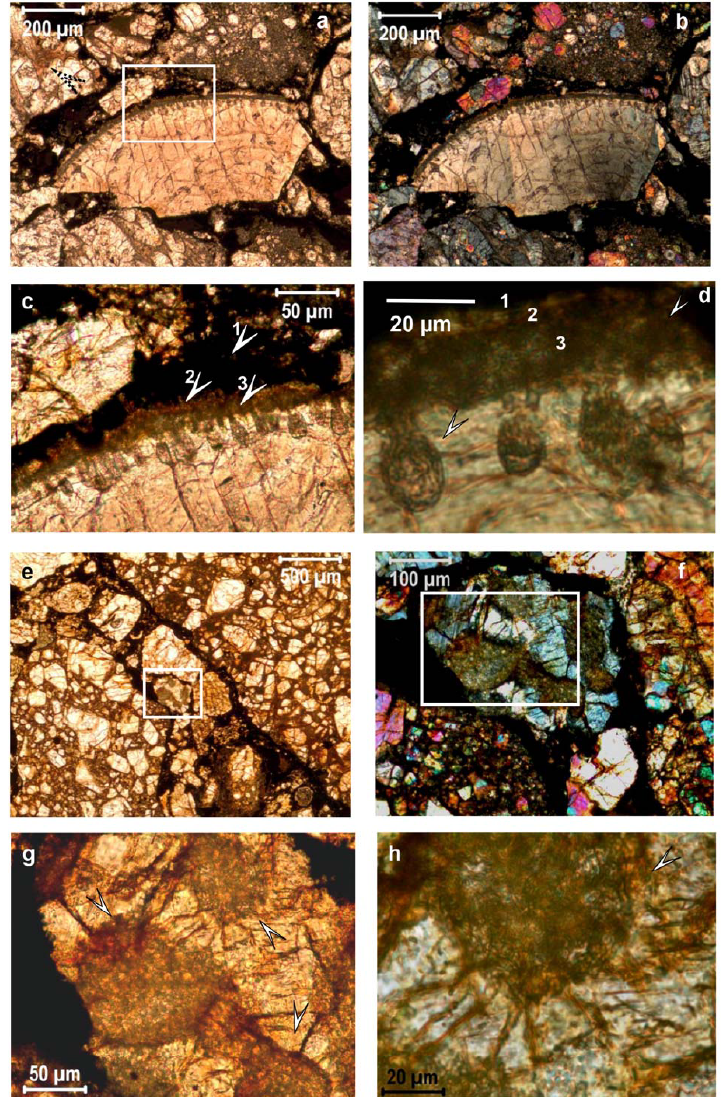
Figure 2. Characteristic microtexture of chondrites. (a) characteristic microtexture of Mező-Madaras chondrite containing chondrules (broken one in the centre), and olivine and pyroxene mineral clasts embedded in opaque fine-grained matrix (1N), dashed arrow show Fe-mobilization; (b) the crossed N photo of (a); (c) higher magnification of marked area on (a), arrows show transition from opaque ma- trix (1) towards the broken chondrule (2- brown part and 3- greenish-brown part), opaque matrix (1) consists of nanocrystalline graphite, weathered olivine and pyroxene, dickite and montmorillonite (SI. 4 - Raman spectroscopy - Mező-Madaras (MM) meteorite), brown part is weathered olivine, pyroxene, ferrihydrite, montmorillonite and dickite (2), part (3) consists of organic matter, ferrihydrite, montmoril- lonite, kaolinite and halloysite determined by Raman spectroscopy (SI. 4 - Raman spectroscopy - Mező-Madaras (MM) meteorite); (d) higher magnification of (c), parts 2 and 3 show characteristic microtexture of the contact zone between the chondrule and the matrix resembling filamentous microbial morphology with pearl necklace-like inner texture and bubble-like microbial colonies (organic matter, olivine, kaolin- ite, dickite, ferrihydrite, montmorillonite and nontronite) invading toward the inner part of the chondrule (weathered Fe-Mg-silicate, dickite, organic matter); (e) characteristic microtexture of Mező-Madaras chondrite (1N); (f) higher magnification of marked area on (e) (crossed N); (g) higher magnification of marked area on (f) (1 N) with intense microbially mediated parts showed by arrows; (h) higher magnification of (g) showing intense microbially mediated parts (arrow); (i) characteristic microtexture of Mező-Madaras chondrite (crossed N); (j) higher magnification of marked area on (i) (1N), the fractures of the quartz are embedded by filamentous microbial forms; (k) characteristic mi- crotexture of Knyahinya chondrite (1N), dashed arrows show Fe-mobilization; (l) higher magnification of marked area on (k) (1N), showing intense microbially mediated parts (arrow); (m) opaque part with Fe-mobilization around (dashed arrows) in Mező-Madaras chondrite with microbial signatures (arrows)(the opaque part is trolitite or metal Fe)(1N, transmitted light); (n) intense microbially mediated parts showed by arrows are embedded in opaque part (reflected